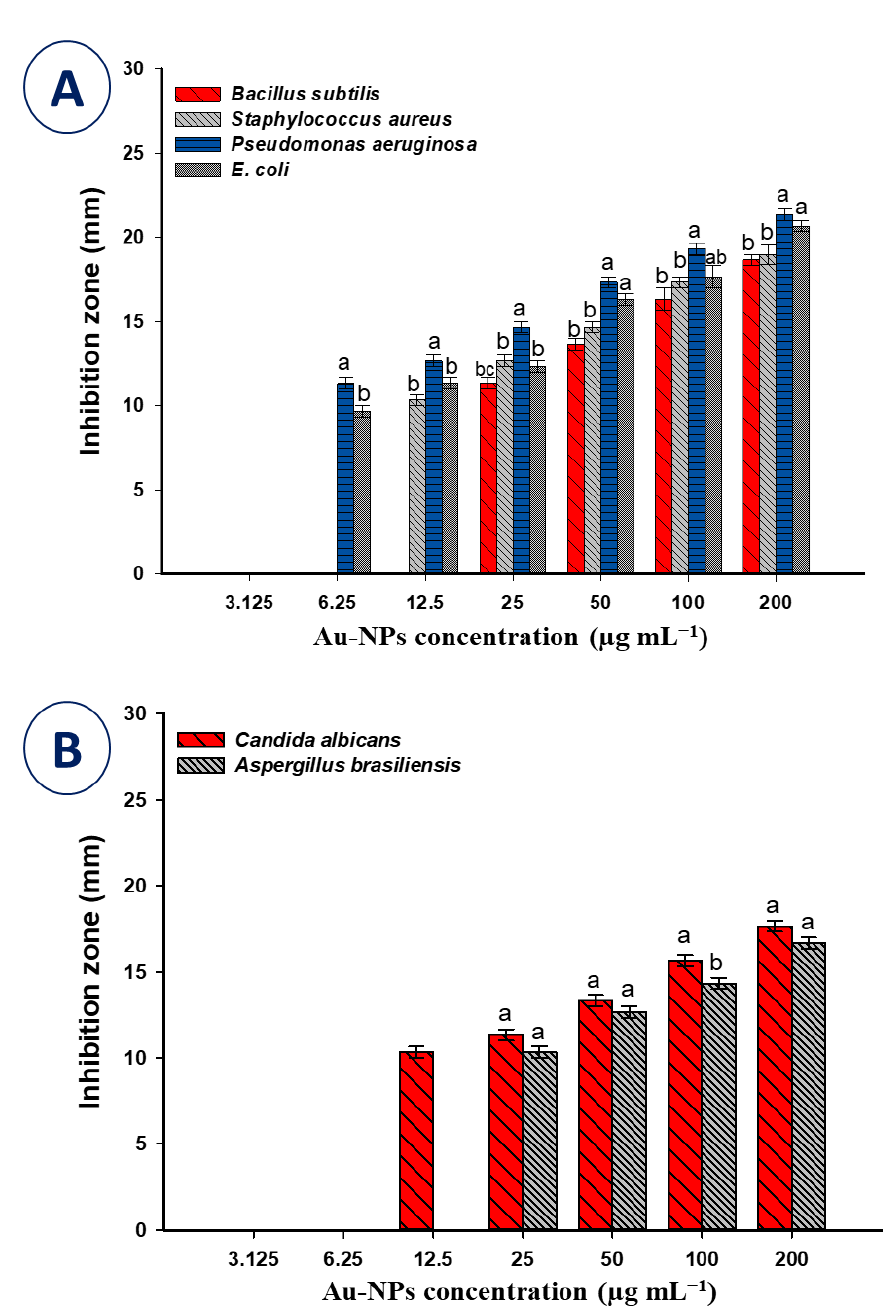
Figure 5. Antimicrobial activity of Z. officinale -mediated green synthesis of AuNPs against ( A ) Gram-positive and Gram-negative bacteria, and ( B ) unicellular fungi, and multicellular fungi. Data are presented as average value ± SD (n = 3). Different letters on the bars at the same concentration indicate that the mean values are significantly different (at p ≤ 0.05).